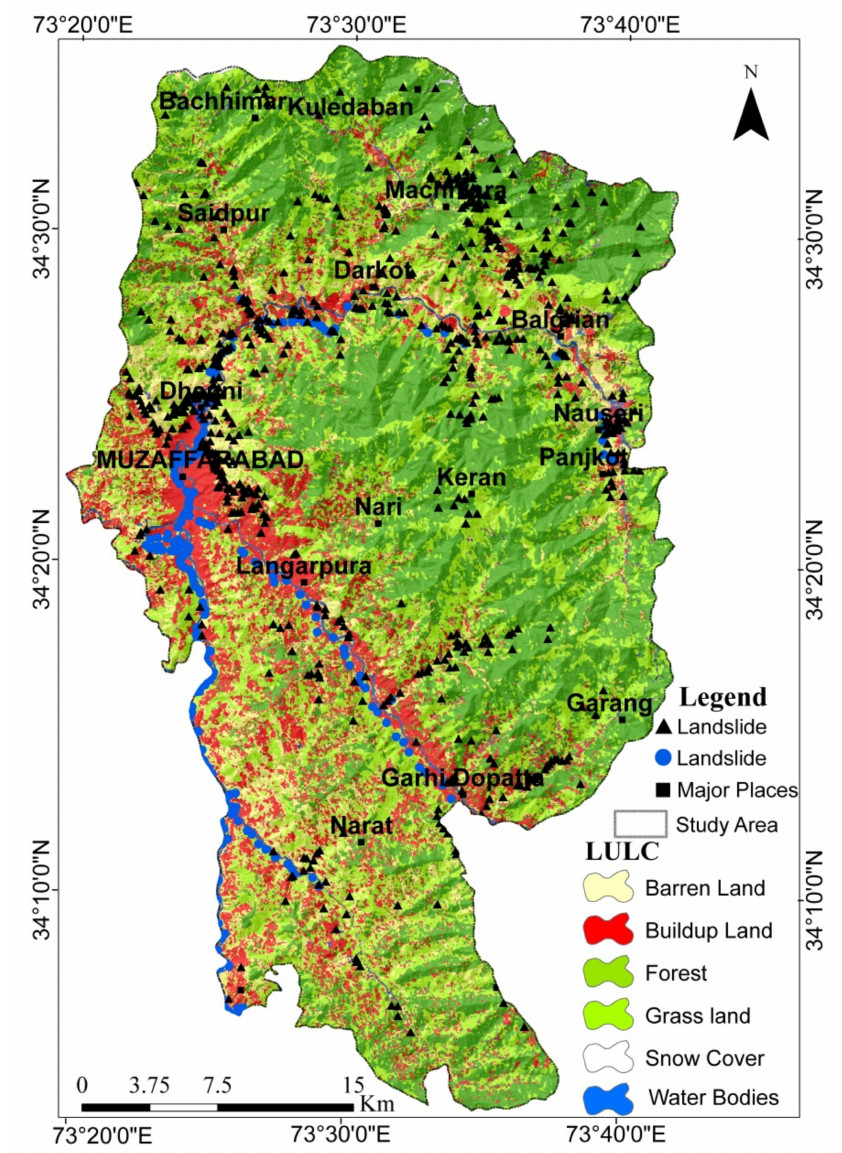
Figure 11. LULC causative factor